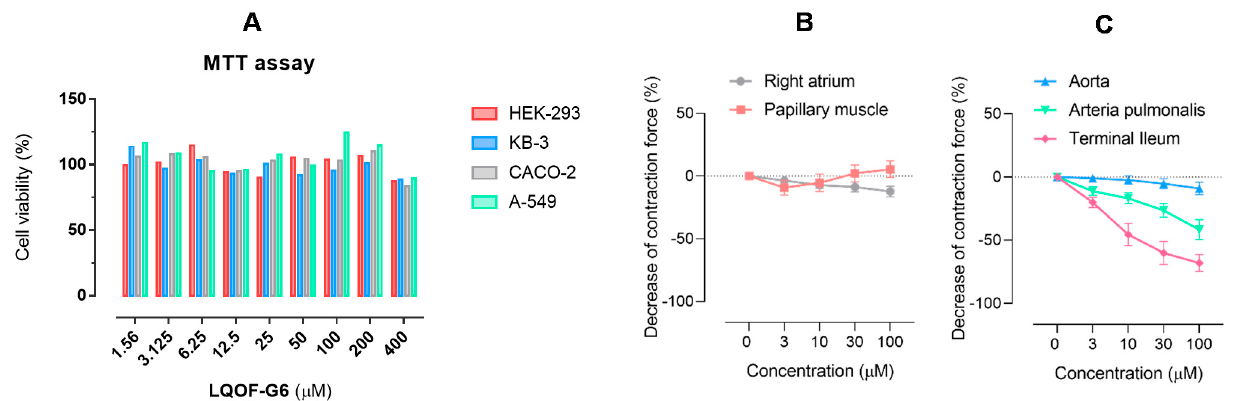
Figure 4. Toxicity results for LQOF-G6 . ( A ) Bar graph showing the average percentage value of cell viability vs. concentration of LQOF-G6 . Each measurement was performed in triplicate and the average value is reported. ( B ) Effect of LQOF-G6 on the spontaneous rate of activity (f) of the guinea-pig right atrium (grey) and the contraction force (f c ) of the papillary muscle (orange). ( C ) Contraction force (f c ) of the aorta (blue), the arteria pulmonalis (green), and the terminal ileum (red).